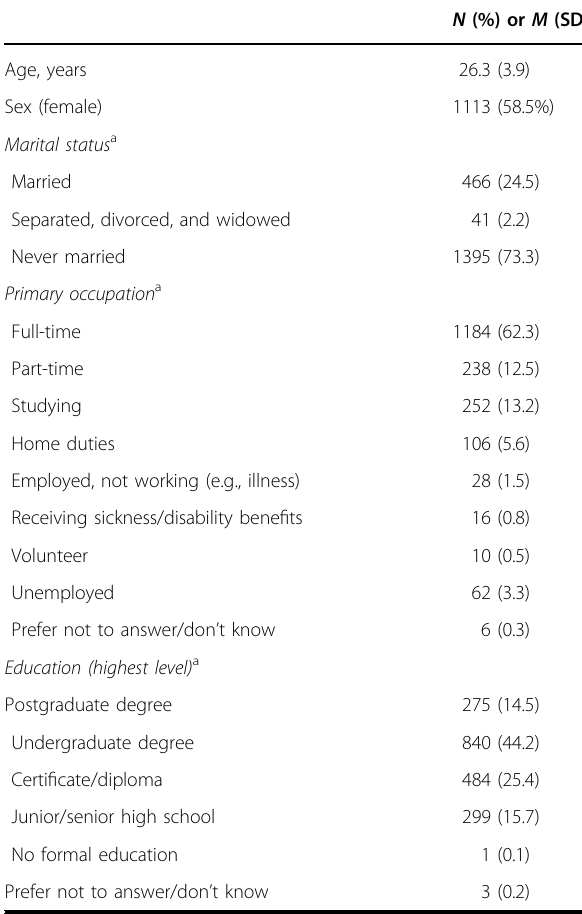
Table 1 Sociodemographic characteristics of sample ( N =